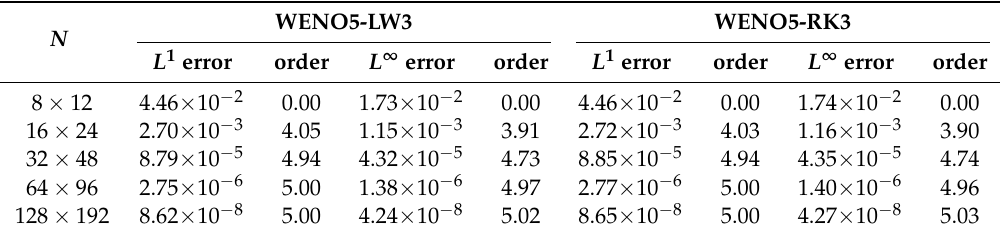
Table 2. L 1 and L ∞ errors and numerical orders of accuracy for density of two-dimensional accuracy test, WENO5-LW3 and WENO5-RK3 with N cells. WENO5-LW3 WENO5-RK3 N L 1